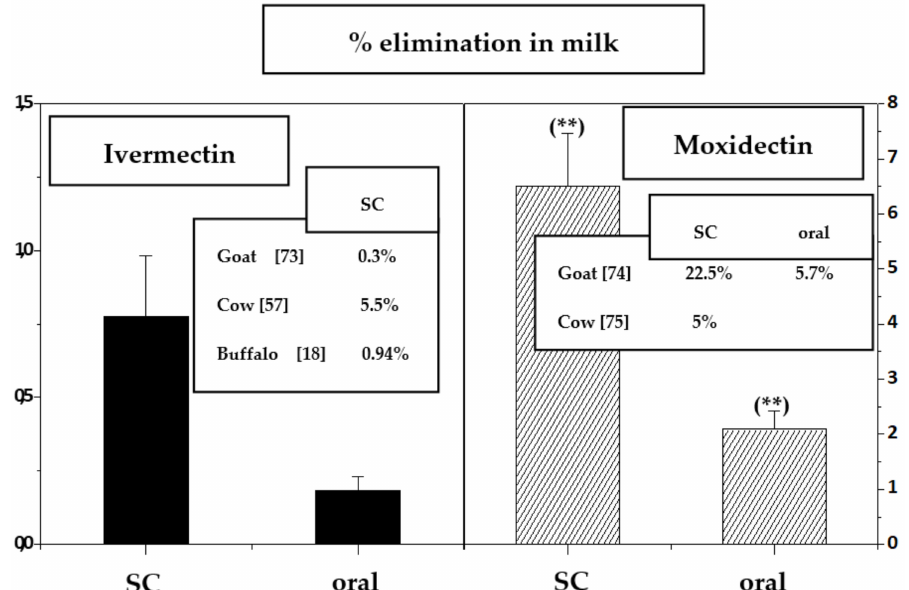
Figure 1. Dose fraction recovered in milk (mean ± SEM) ( n = 5). The percentages of MXD excreted in sheep ´ s milk after subcutaneous (SC) or oral treatment (0.2 mg/kg) are statistically different at p < 0.01 (**) from those obtained after IVM administration. The insert shows the percentages of elimination after SC or oral treatment in different species. Source: Adapted from Imperiale et al.